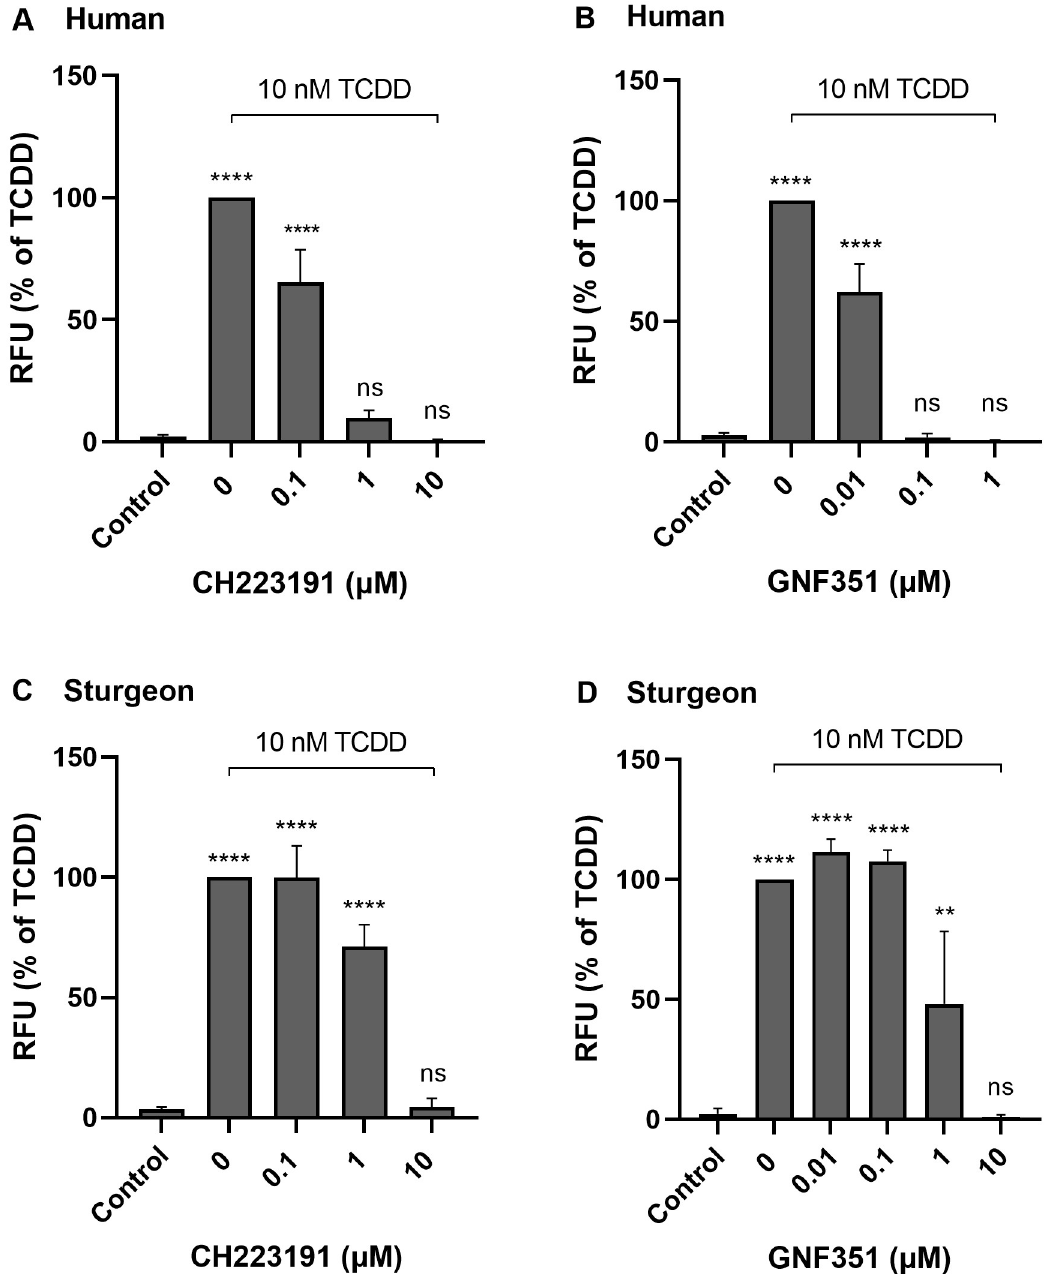
Fig 4. Human and sturgeon epidermal cell responses to TCDD. Human (A, B) and sturgeon (C, D) epidermal cells were pre- treated with indicated concentrations of AHR inhibitors (CH223191 or GNF351) 1 hr before TCDD exposure. After overnight incubation, the cells were treated with 7-ethoxyresorufin in serum free medium for 2 hr and the medium was harvested for EROD assay performed as described in the Methods. The CYP1A activity was corrected for background activity measured from fresh medium containing 7-ethoxyresorufin and expressed as a percent of the CYP1A activity obtained from cells treated with TCDD (set to 100%). Results are presented as the mean ± SD of three independent experiments. Significant differences from untreated control were calculated (one-way ANOVA and Dunnett’s post hoc test) with GraphPad Prism 9 (ns, not significant different; �� , p < 0.01; ���� , p < 0.0001).